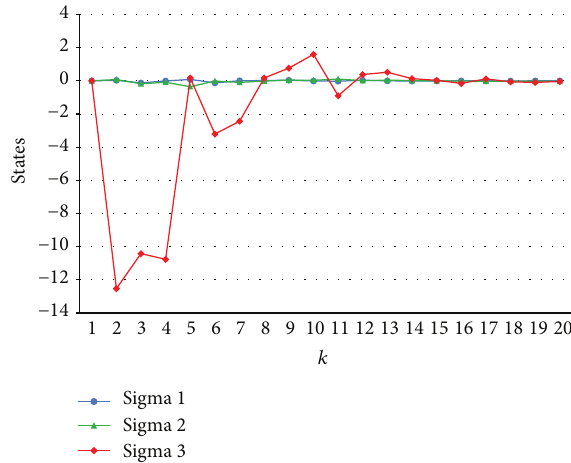
Figure 7: Sliding surface signal for subsystem ( 𝜎 1 (𝑘) , sigma 1), subsystem 2 ( 𝜎 2 (𝑘) , sigma 2), and subsystem 3 ( 𝜎 3 (𝑘) , sigma